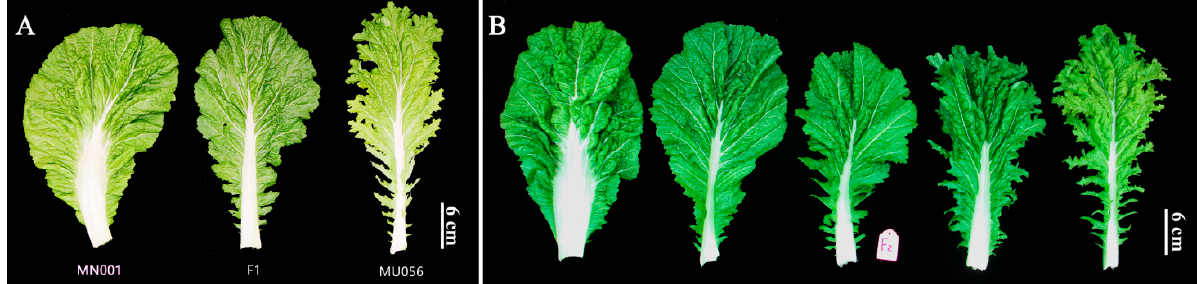
Figure 1. Phenotypic analysis of the lobed leaf. Representative photographs of lobed leaf in leaf mustard. ( A ) Parents and F 1 generation; ( B ) F 2 generation segregation phenotype.